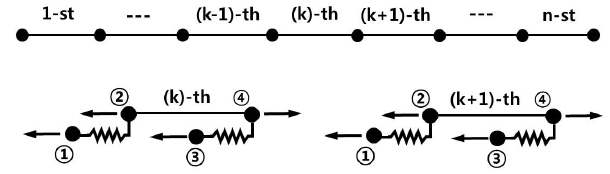
Figure 6. Modeling of steel tube for matrix method.